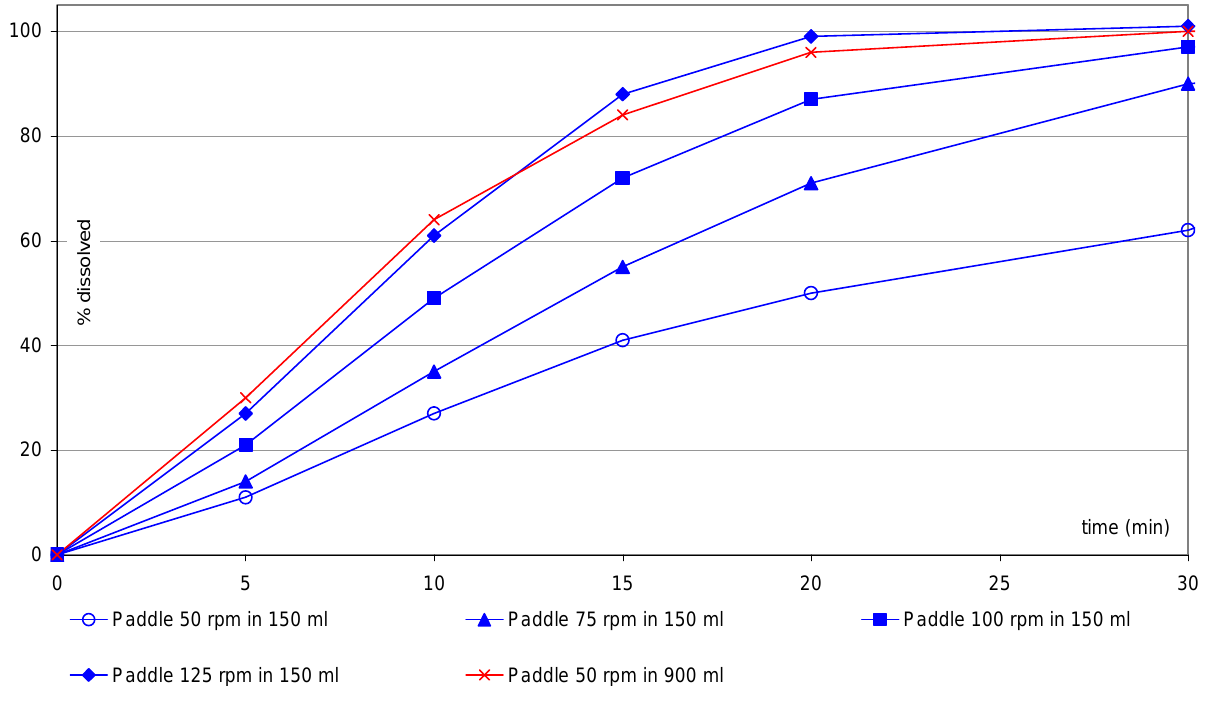
Figure 6. IR(2) tablets: comparison of small vessel accessories versus one liter vessel.